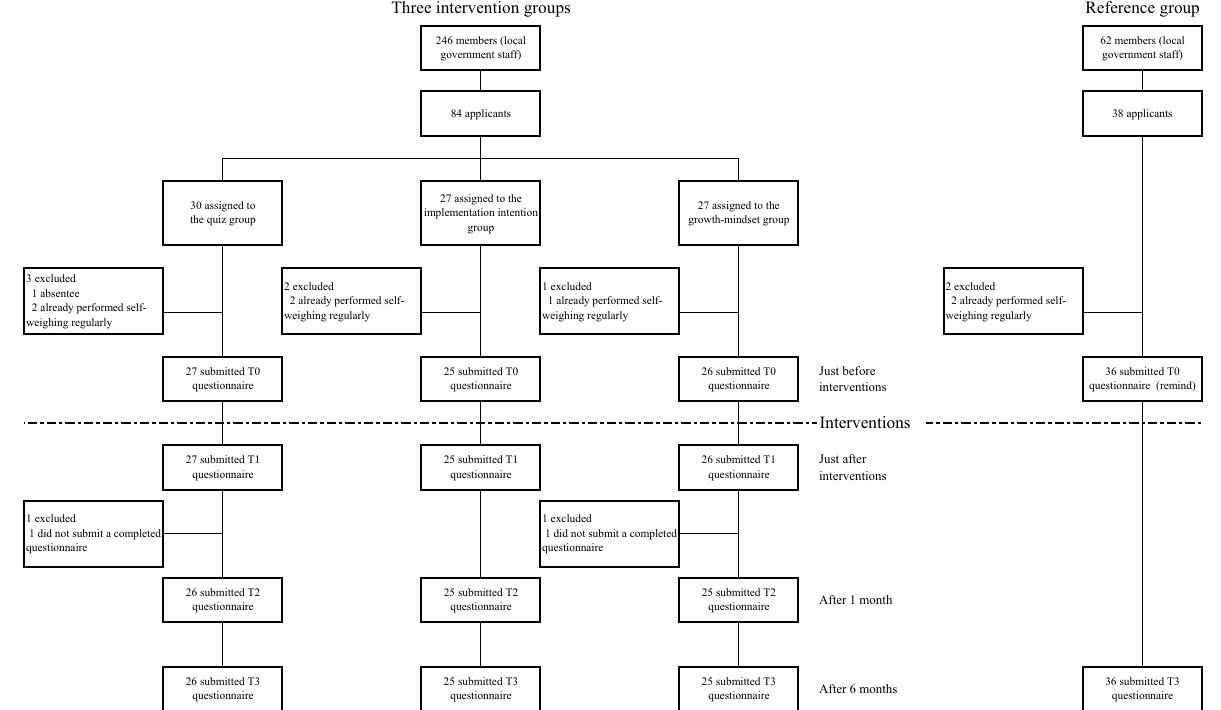
Figure 1. Trial profile of the three nudge groups and reference